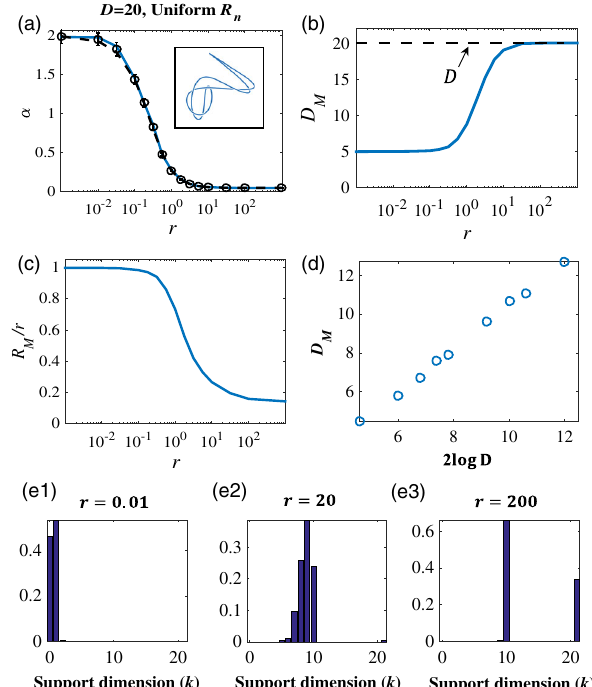
FIG. 10. Linear classification of D -dimensional ring manifolds, ffiffiffiffiffiffiffiffiffiffiffiffiffi p r . (a) Classification capacity for D ¼ with uniform R ð 2 =D Þ n ¼ 20 as a function of r with m ¼ 200 test samples (for details of numerical simulations, see SM [16], Sec. S9): mean-field theory (blue lines), spherical approximation (black dashed lines), numerical simulations (black circles). Inset: Illustration of a ring ∼ D in manifold. (b) Manifold dimension D , which shows D M M the large r limit, showing the orthogonality of the solution. =r Þ , as a (c) Manifold radius relative to the scaling factor r , ð R M =r Þ becomes small implies that the function of r . The fact that ð R M manifolds are “ fully supporting ” to the hyperplane, showing the small radius structure. (d) Manifold dimension grows with affine ffiffiffiffiffiffiffiffiffiffiffiffiffiffi p 2 log D dimension, D , as 2 log D for small r ¼ ð 1 = 2 Þ in the scaling regime. (e1) – (e3) Distribution of support dimensions. (d1) r ¼ 0 . 01 , where most manifolds are either interior or touching; (d2) r ¼ 20 , where the support dimension has a peaked distribution, truncated at ð D= 2 Þ ; (d3) r ¼ 200 , where most support dimensions are ð D= 2 Þ or fully supporting at D þ 1